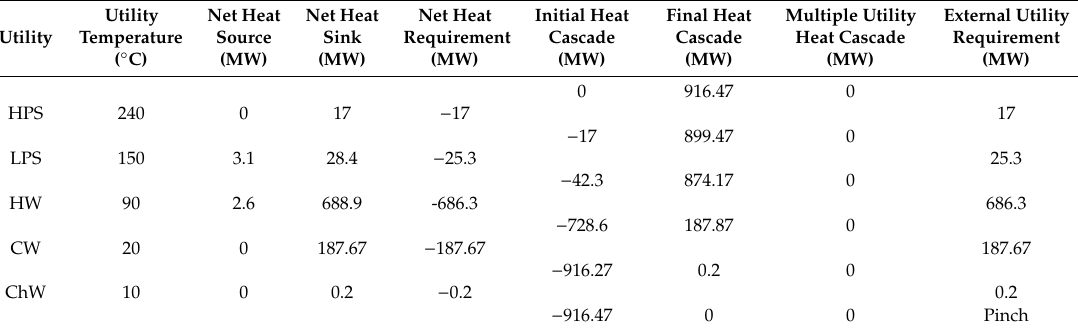
Table 8. Total Site PTA (TS PTA) for all industrial plants from 6 to 17 h.